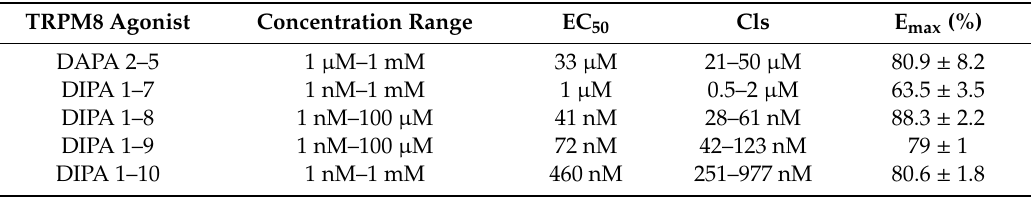
Table 1. Potency and e ffi cacy of the tested TRPM8 agonists (expressed as EC 50 and E max respectively) in determining reduction of human colon spontaneous contractions. TRPM8 Agonist Concentration Range EC 50 Cls E max (%) DAPA 2–5 1 µ M–1